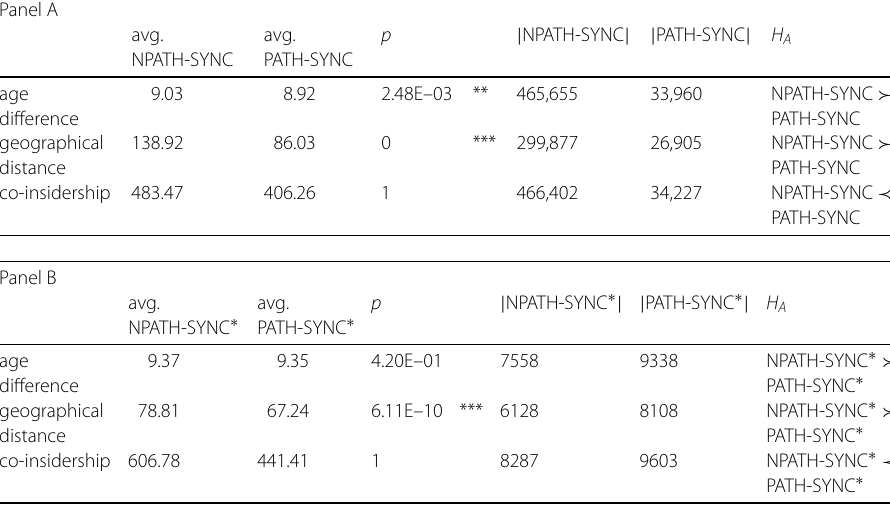
Table 4 One-sided Welch’s t -test on the differences in age, length of co-insidership and geographical distance between NPATH-SYNC (Eq. (14)) and PATH-SYNC (Eq. (13)) sets (Panel A), and NPATH-SYNC ∗ (Eq. (16)) and PATH-SYNC ∗ (Eq. (15)) sets (Panel B). Trade synchronization between investors is validated at the significance level of α = 0.01. Here, H A is the direction of the alternative hypothesis. The units for the co-insidership are trading days, age difference in years, and geographical distance in